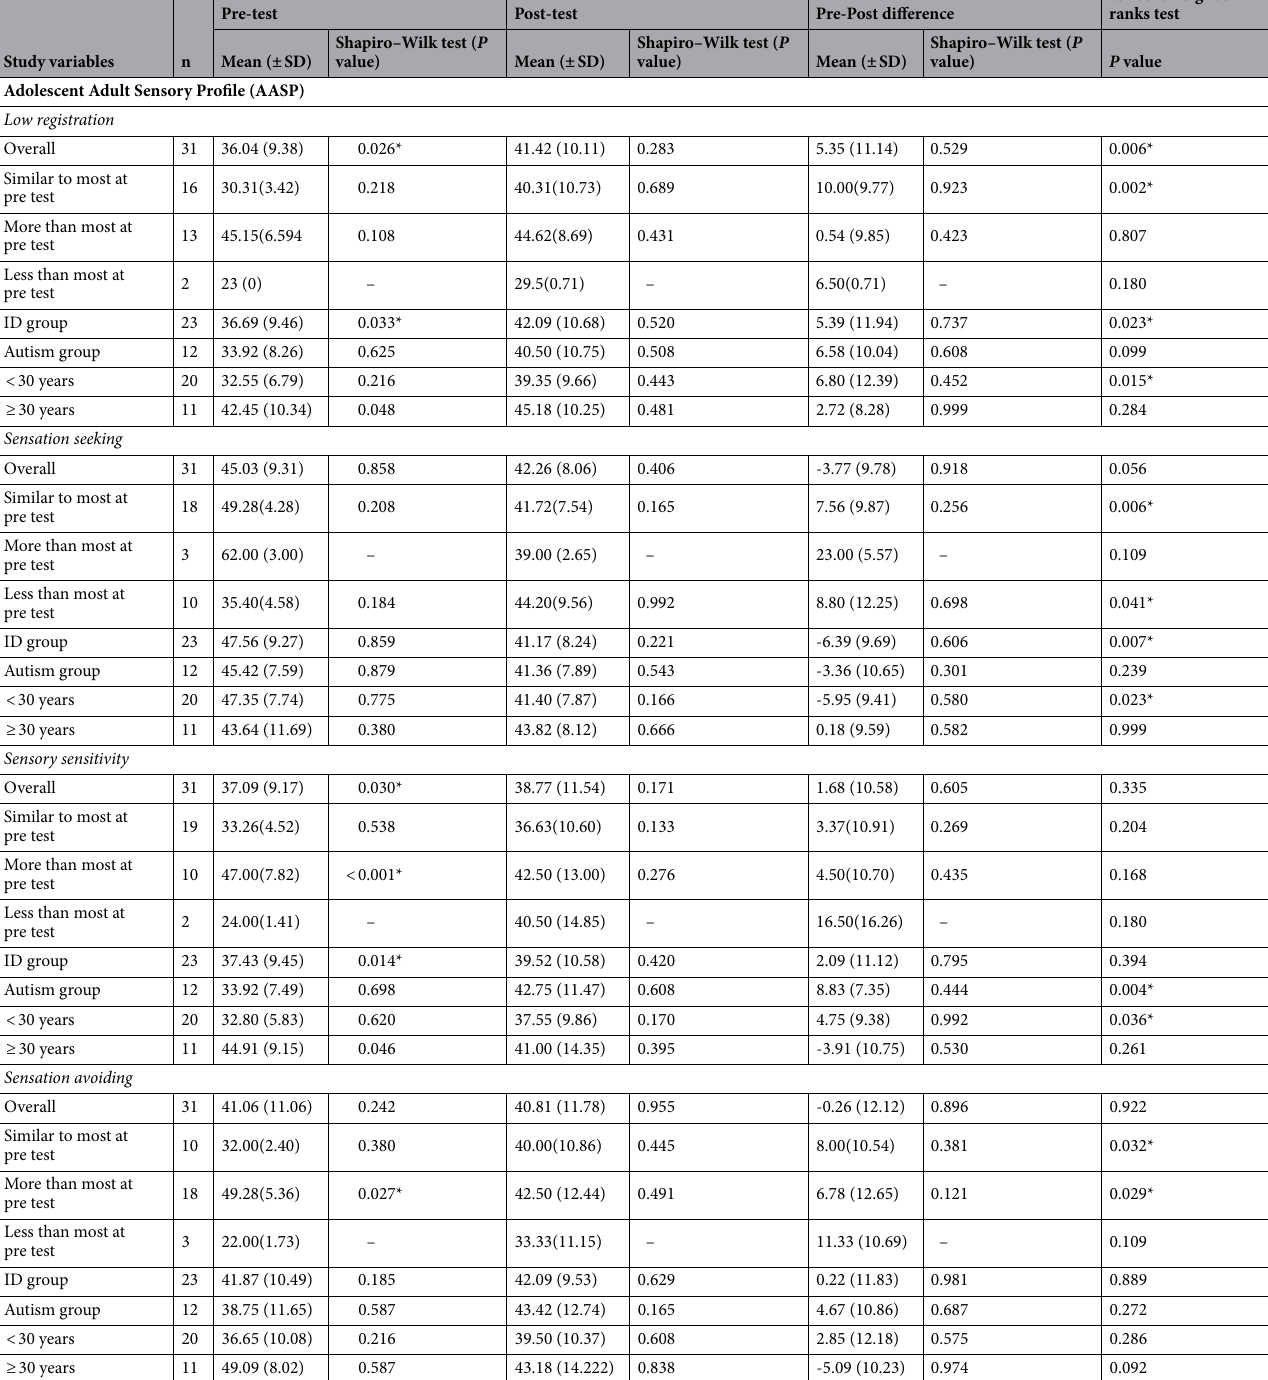
Table 2. Pre-post statistical analysis of sensory processing (AASP) with Wilcoxon Signed Ranks Test. Asterisk indicatesstatistical